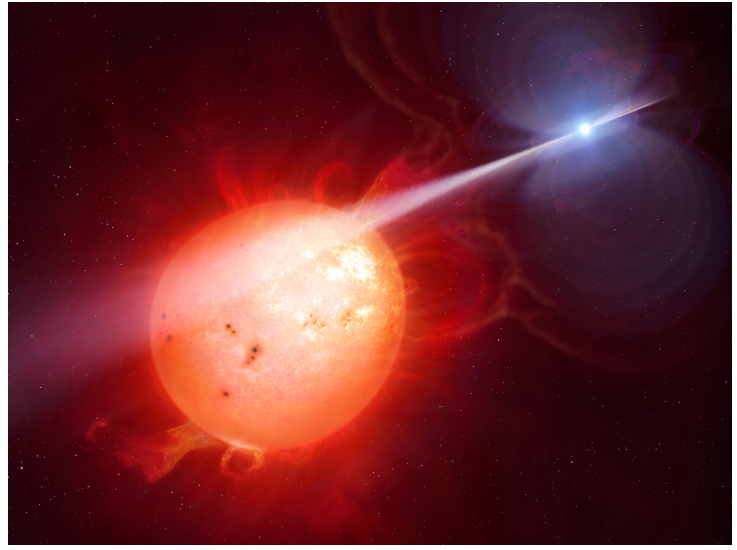
Figure 3. Artist’s impession of the white dwarf pulsar system, AR Sco. Credit: Mark Garlick/University of